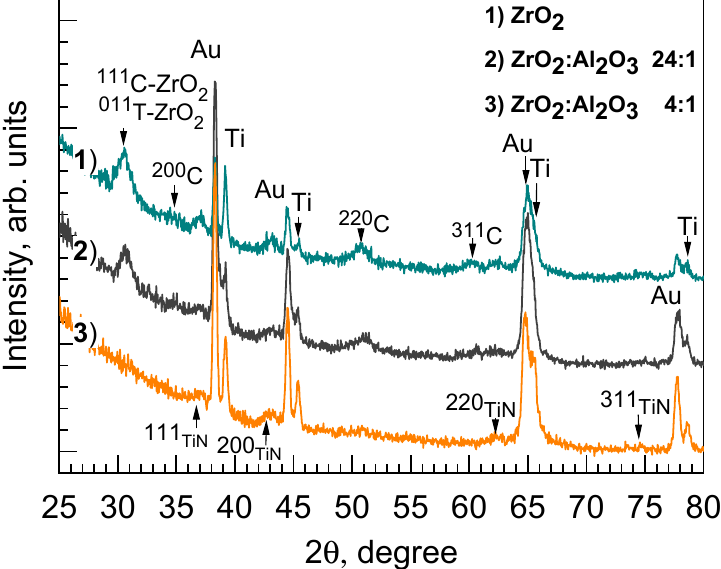
Figure 3. GIXRD patterns from (1) pure ZrO 2 and (2,3) periodically layered ZrO 2 :Al 2 O 3 films deposited by applying single Al 2 O 3 deposition cycles between successive ZrO 2 cycles in ratios of (2) 24:1 and (3) 4:1. Patterns were measured from the films supplied with top Au/Ti electrodes. Miller indexes are assigned to the cubic phase of ZrO 2 , in addition to the reflections attributed to top metal and bottom TiN electrode films.